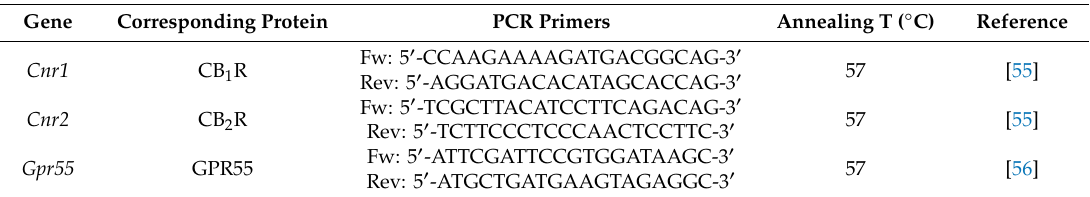
Table 2. List of the primers used for quantitative real-time PCR